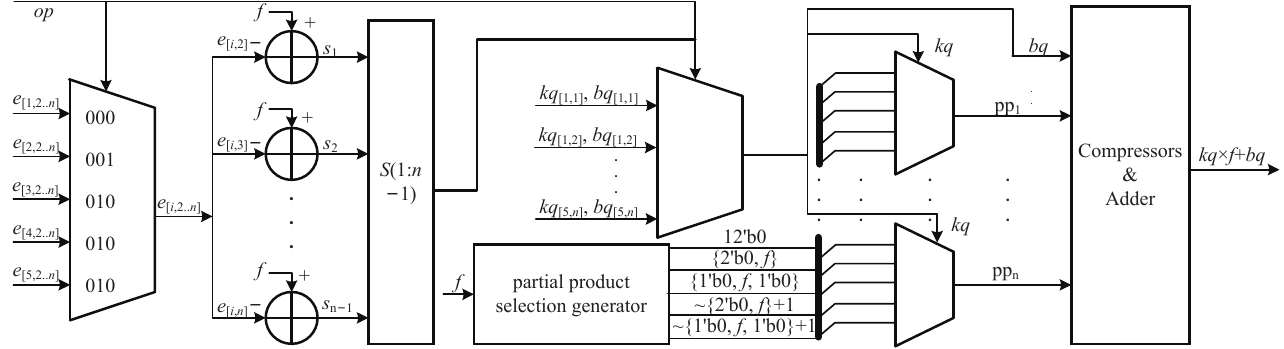
Figure 13. Proposed hardware architecture of the single-function implementation. The symbols f 2 , f 3 and f n represent the starting points of the 2nd, 3rd and n th segments, respectively. The symbols s 1 to s n − 1 denote the signs of the outputs of the comparators.